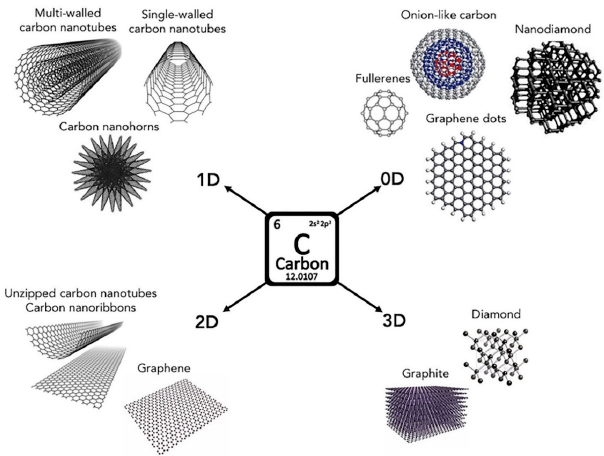
Figure 1. Carbon allotropes that are commonly found in nature. Reprinted with permission from